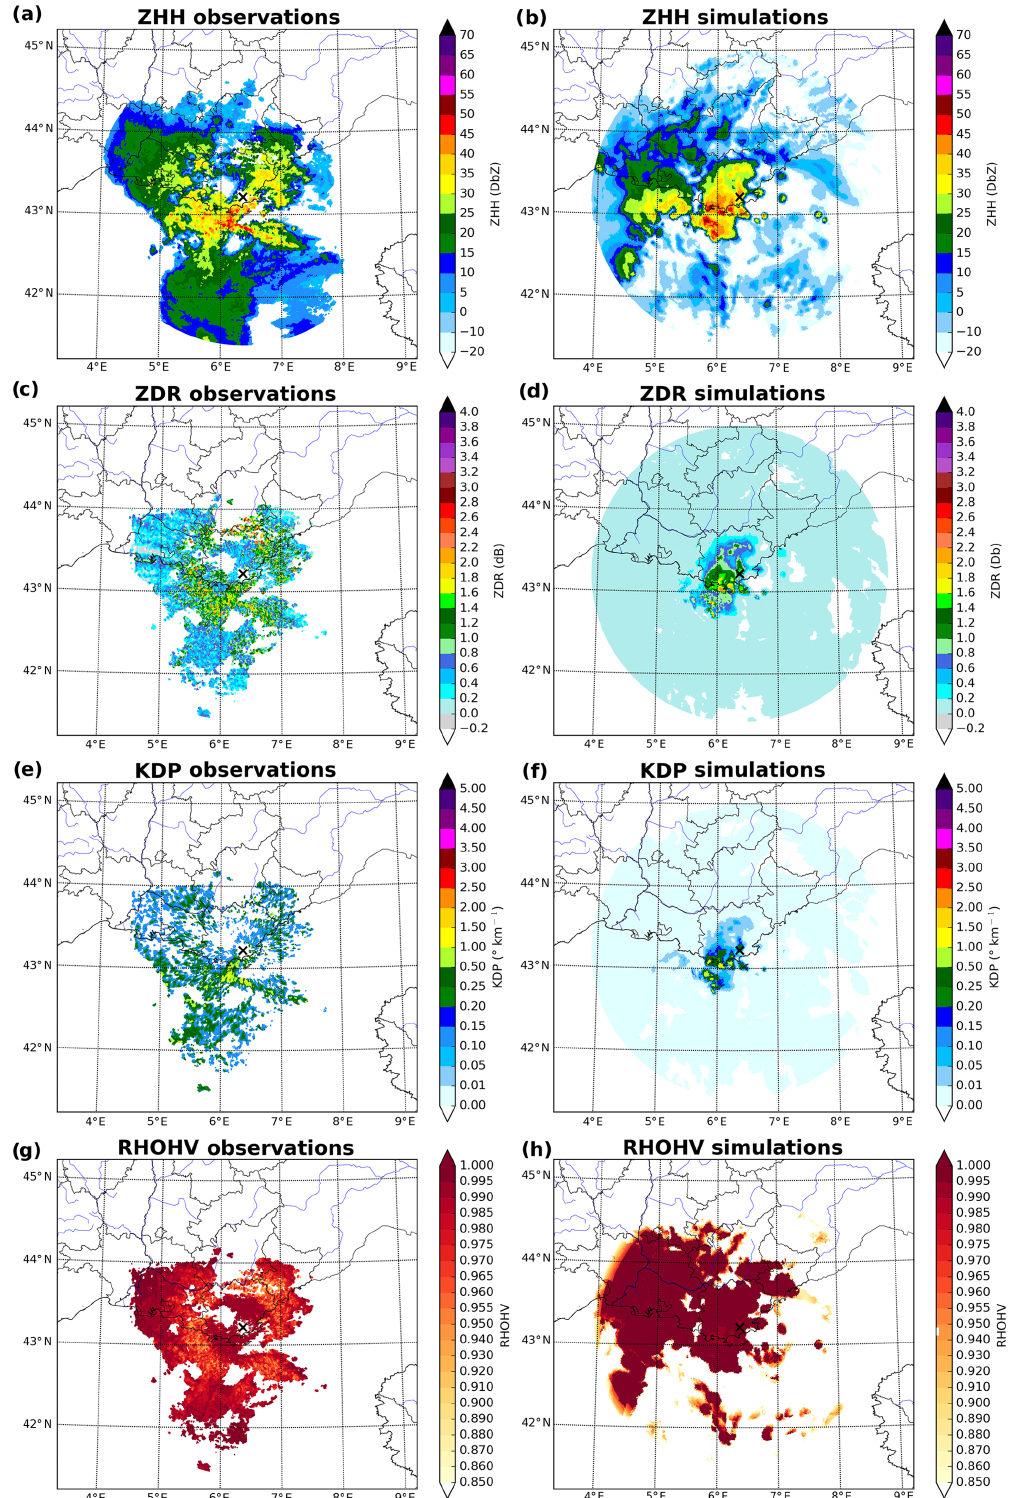
Figure 1. Observed (a, c, e, g) and simulated (b, d, f, h) Z HH (a, b) , Z DR (c, d) , K DP (e, f) and ρ HV (g, h) for the Collobrières radar the 10 October 2018 at 14:00UTC (elevation: 2.2 ◦